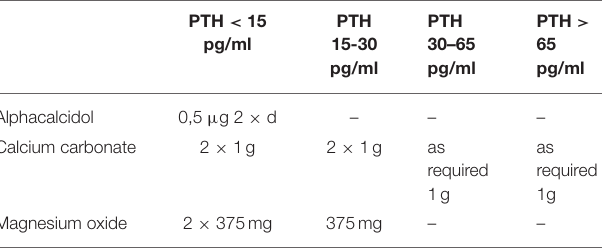
TABLE 2 | Postoperative procedure dependent on PTH levels on first postoperative